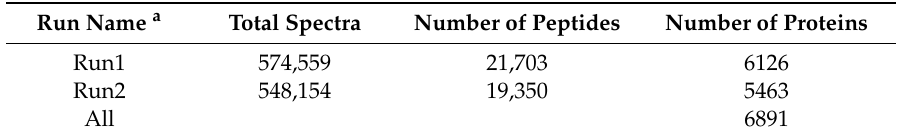
Table 1. Statistics of the proteins identified by iTRAQ in two sugarcane cultivars inoculated with Xanthomonas albilineans (LC P85–384 resistant and ROC20 susceptible to leaf